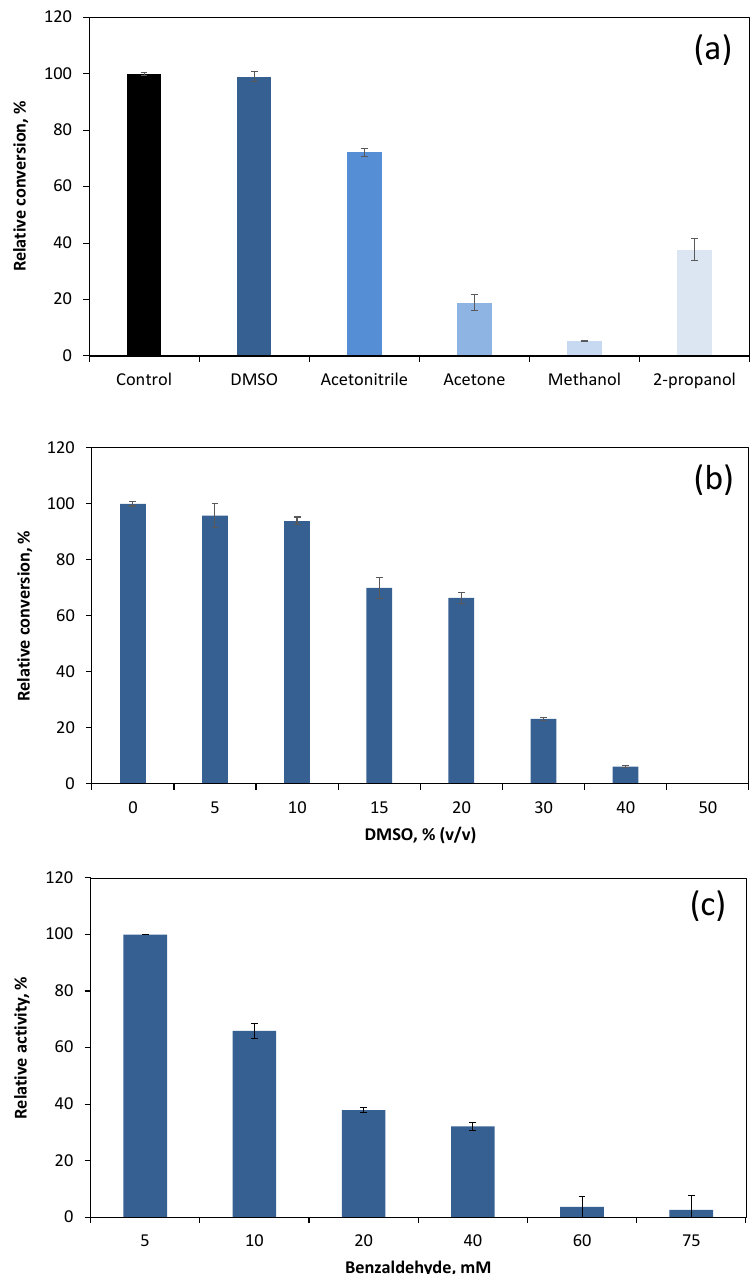
Figure 2. Relative conversion of benzaldehyde to benzyl alcohol by G. arilaitensis 232 cells after 2 h in an aqueous system with a cosolvent. ( a ) Conversion of benzaldehyde in the presence of different organic solvents used as cosolvent in relation to a control without organic solvent. ( b ) Influence of DMSO concentration on the conversion of benzaldehyde relative to a system without DMSO. ( c ) Effect of benzaldehyde concentration on the activity of the biocatalyst, relative to a system with 5 mM benzaldehyde. Results are the average of three independent bioconversions. Data are presented as mean ± standard deviation.